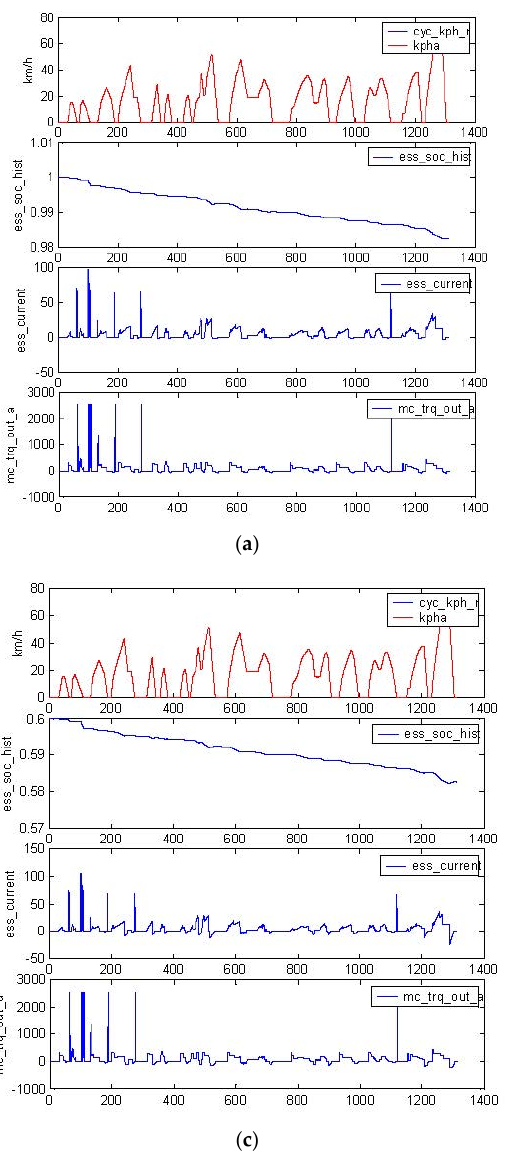
Figure 21. Simulation results of a single case with different initial SOCs: ( a ) SOC = 1, ( b ) SOC = 0.8, ( c ) SOC = 0.6, and ( d ) SOC = 0.4.